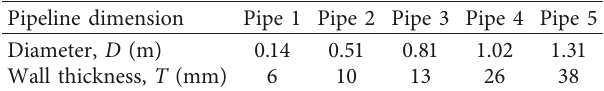
Figure 6: Influence of the distance between a joint and the locus of maximum ground settlement on a jointed pipeline. (a) Influence of the distance between a joint and the locus of maximum ground settlement on maximum joint rotation. (b) Influence of the distance between a joint and the locus of maximum ground settlement on maximum pipe bending strain. (c) Influence of the distance between a joint and the locus of maximum ground settlement on maximum vertical Table 1: Summary of the pipeline dimension.